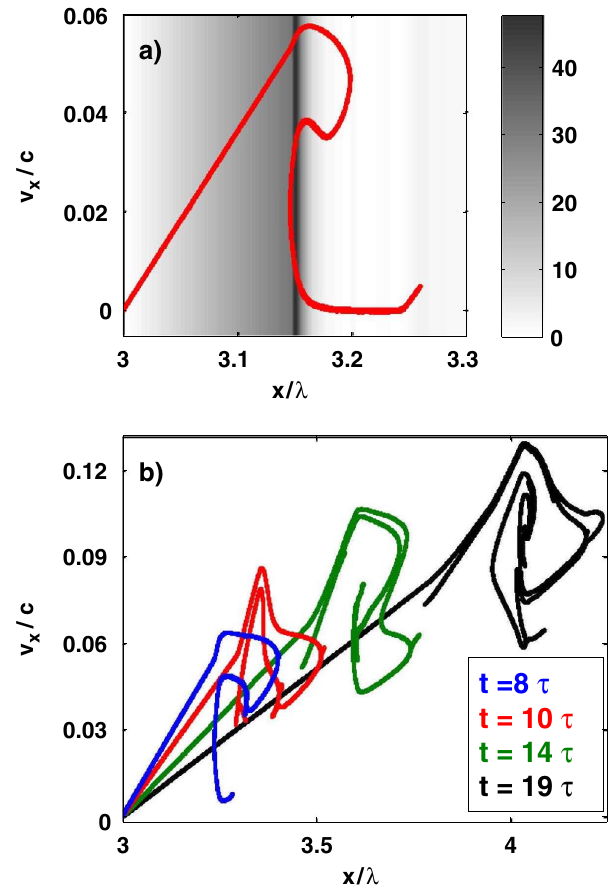
FIG. 4. (Color) (a) Ion phase space at the interaction time 4 (cid:2) . The gray color transition in the background denotes the actual strength of the electrostatic field in the units of TV = m (see the colorbar for the scale). (b) Snapshots of the ion phase space at time 8, 10, 14, and 18 (cid:2) . The loop originates from the combina- tion of the front side acceleration and the ballistic evolution. The simulation parameters are the same as in Fig.